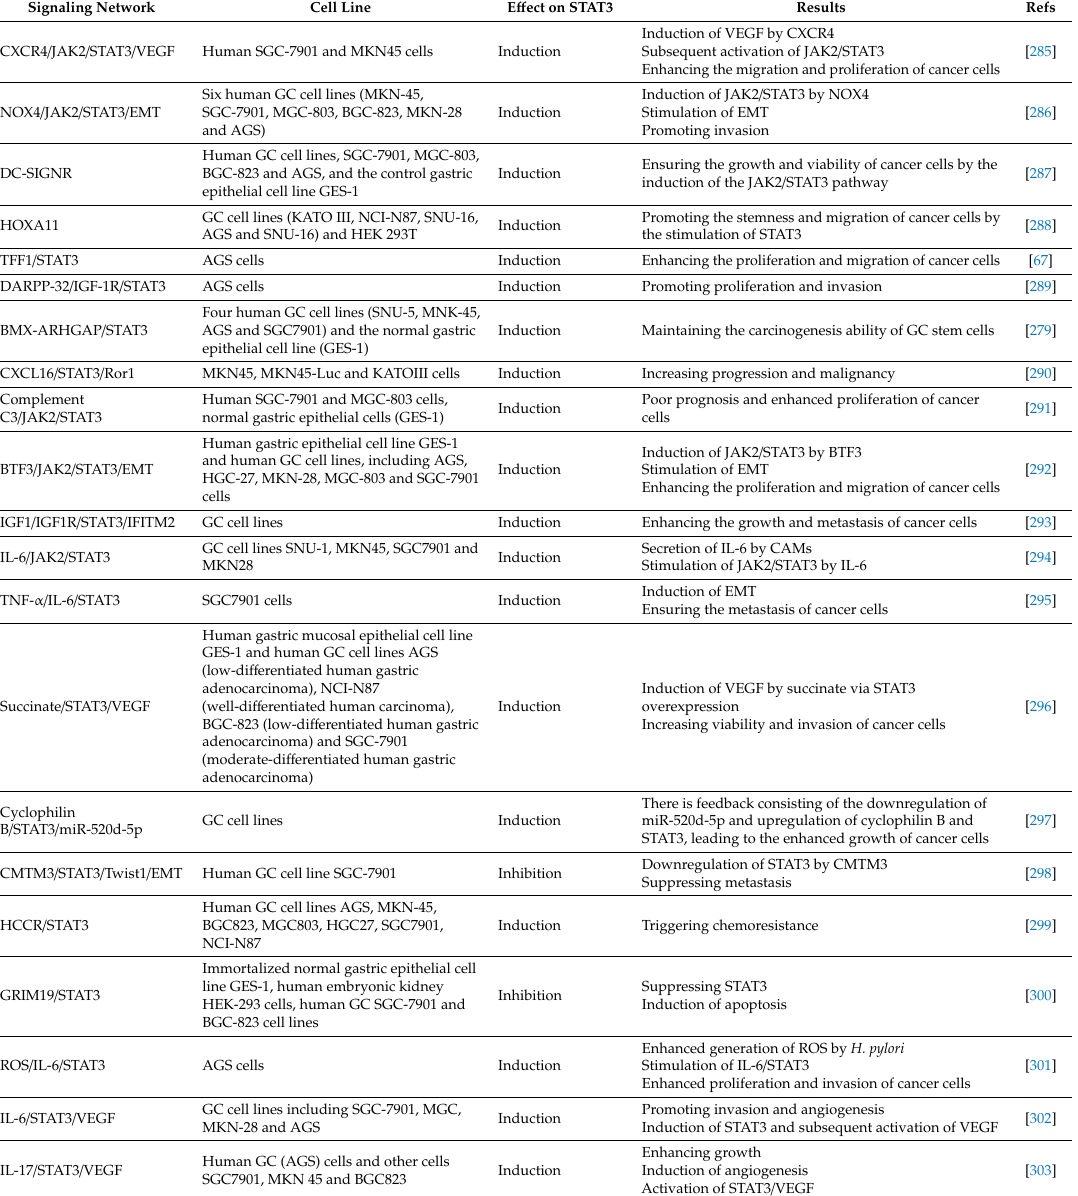
Table 6. Molecular pathways targeting STAT3 in GC